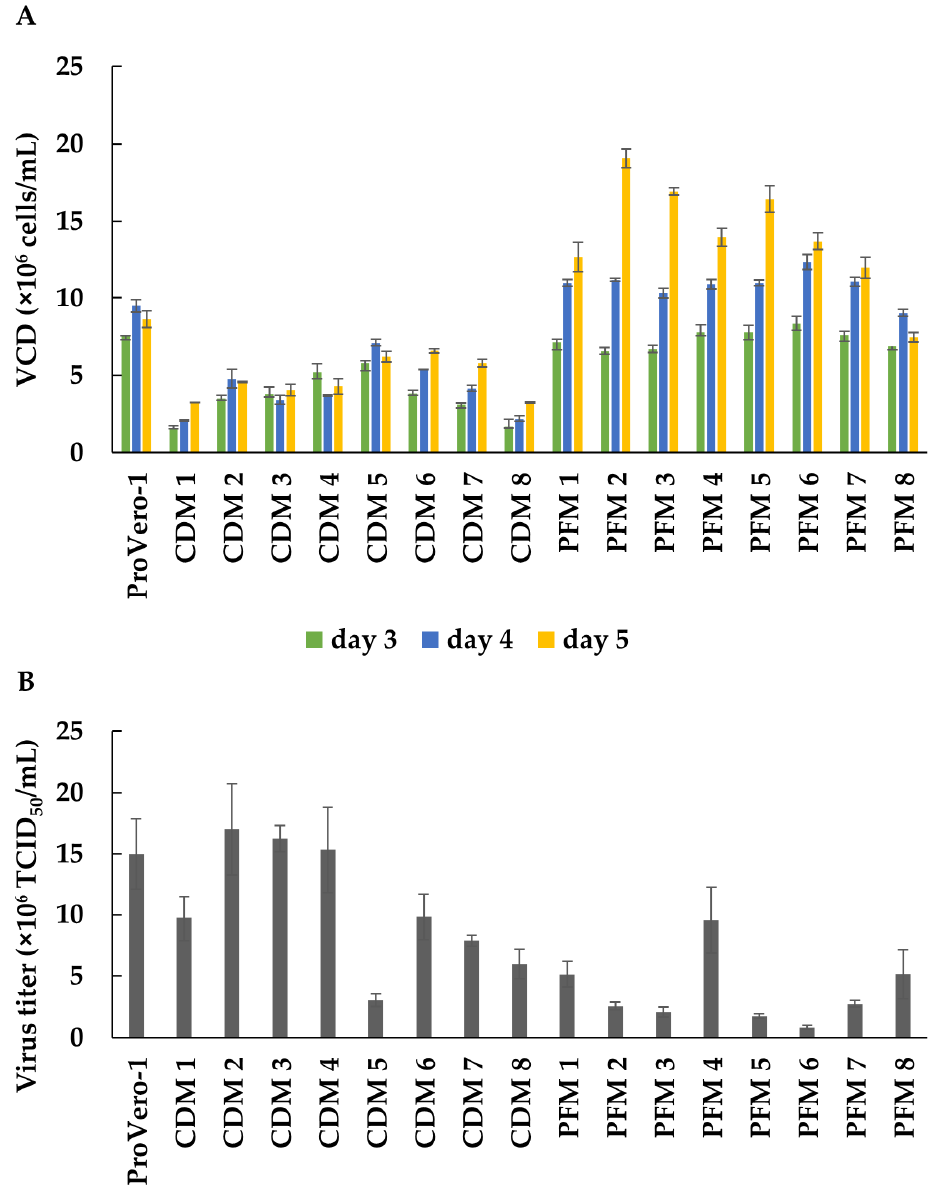
Figure 4. Serum-free medium was developed for increasing FMDV productivity. The growth profile of BHK-S cells was monitored using eight CDM prototypes and eight PFM prototypes ( A ). FMDV titers were measured on the third day of BHK-S cell culture using the indicated prototype media ( B ). Each experiment was carried out in triplicate. Data expressed as mean ± standard devi- ation.